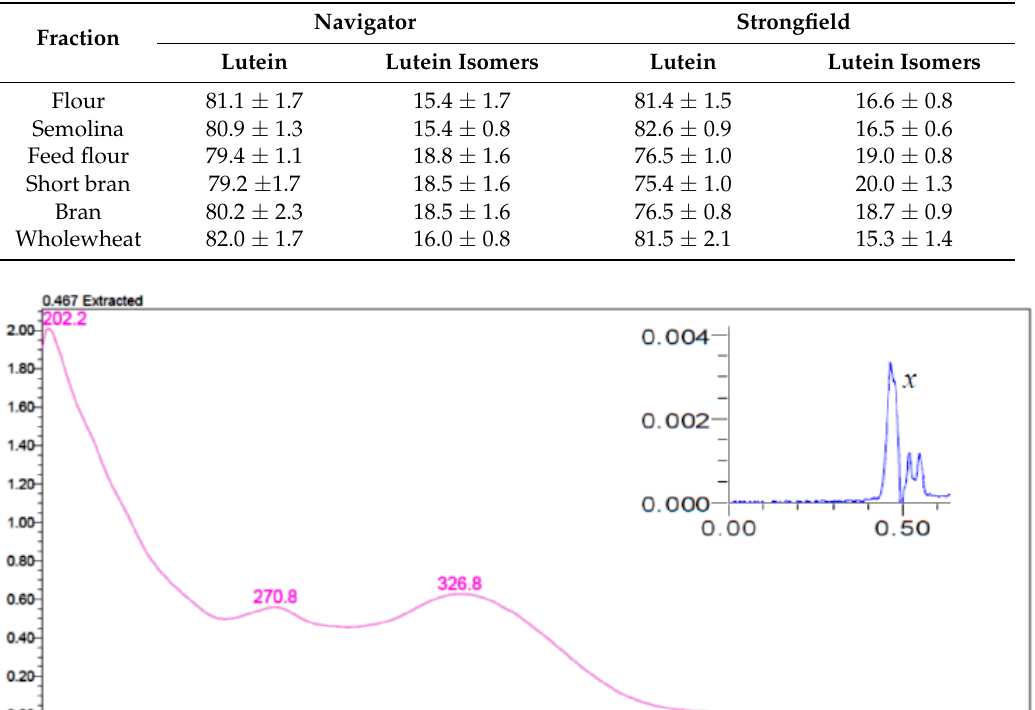
Table 2. Percentage composition of lutein in the durum wheat milling fractions excluding the unknown compounds.